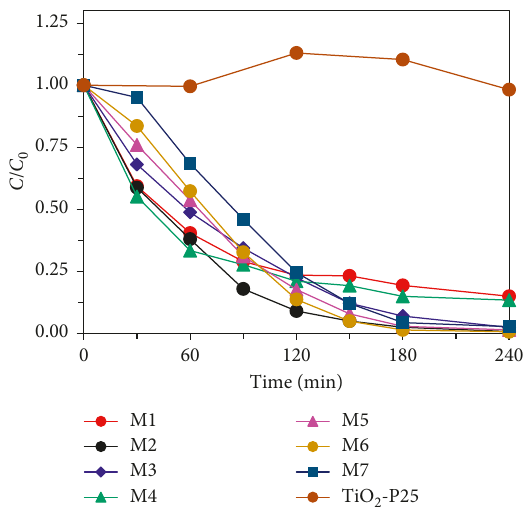
Figure 10: Relative degradation rate of 100ppm of 2,4,6-trichlorophenol.